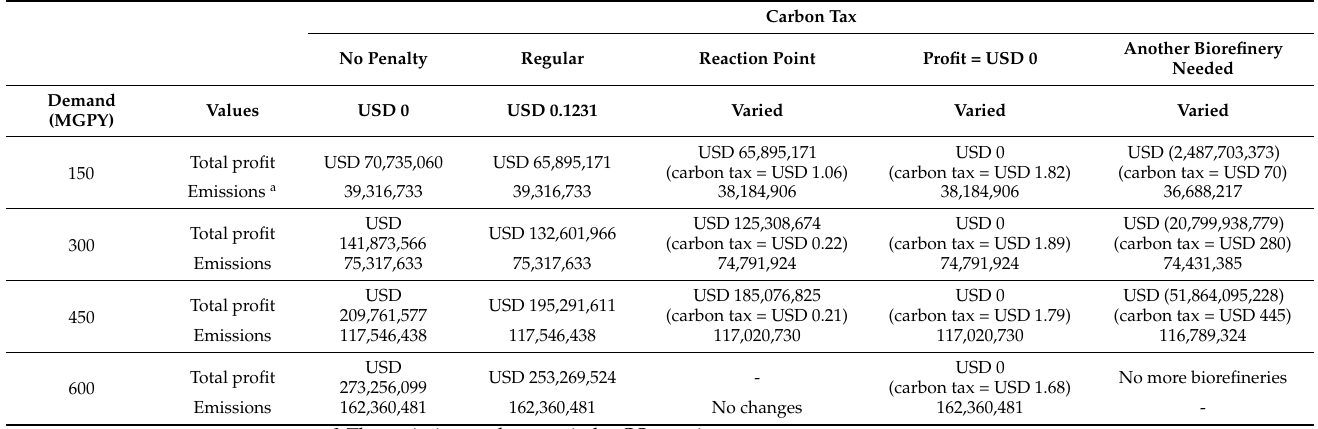
Table 4. Emissions and profit with different demand levels under different carbon taxes (emissions